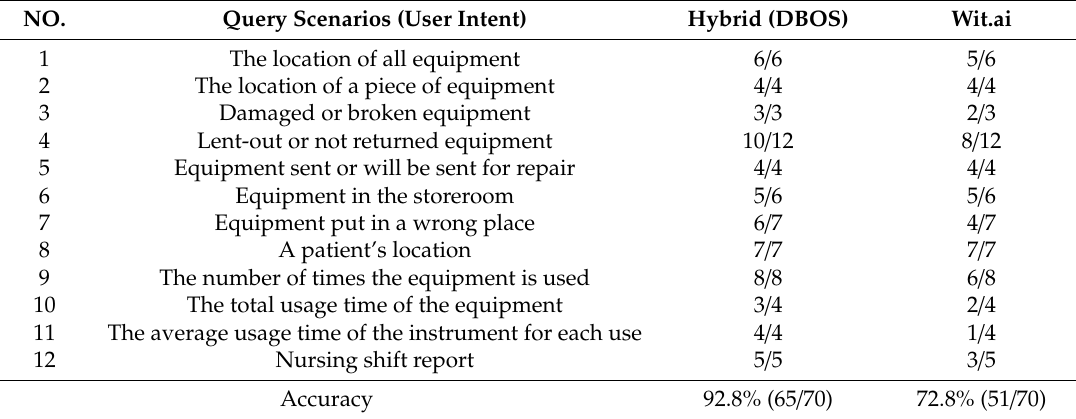
Table 3. Comparison of DBOS and